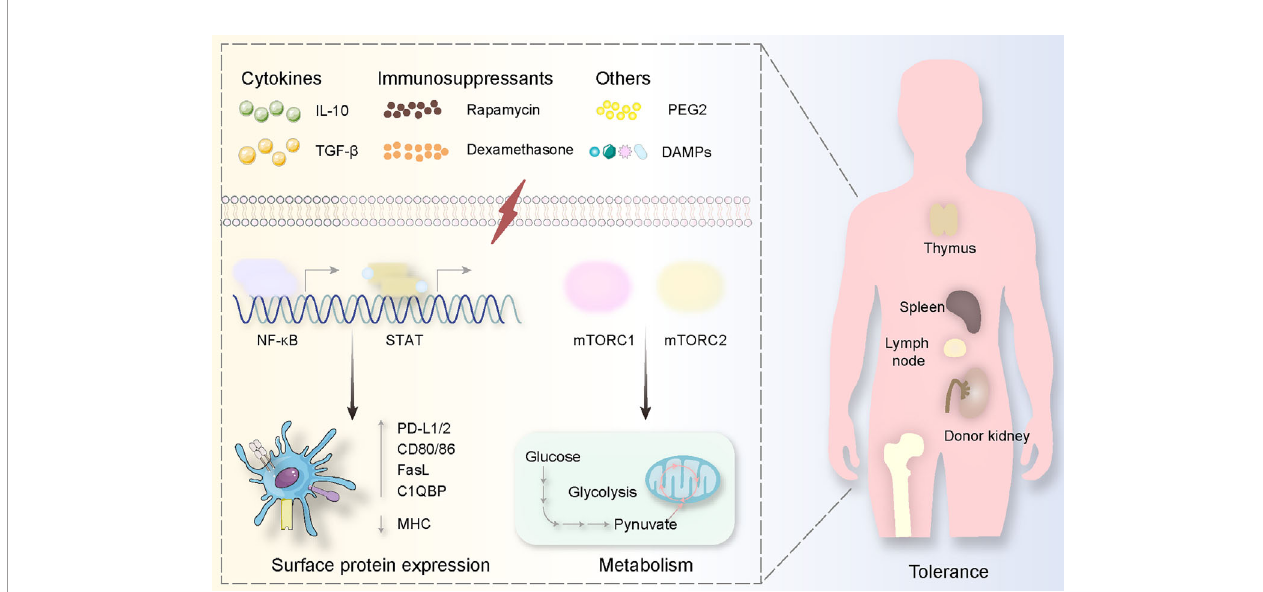
FIGURE 4 | Tolerogenic DCs are usually generated via speci fi c substances. These stimulations derived from cytokines (IL-10, TGF- b ), immunosuppressants (Rapamycin, Dexamethasone), and others (PEG2, DAMPs) mediate signal pathways involving NF- k B and mTOR activation, causing surface protein expression alterations (highly expressing PD-L1/2, CD80/86, FasL C1QBP while decreasing MHC expression) and metabolism changes (from glucose to pynuvate). All these procedures happen in the donor kidney and the immune organs including the thymus, spleen, lymph node, and bone